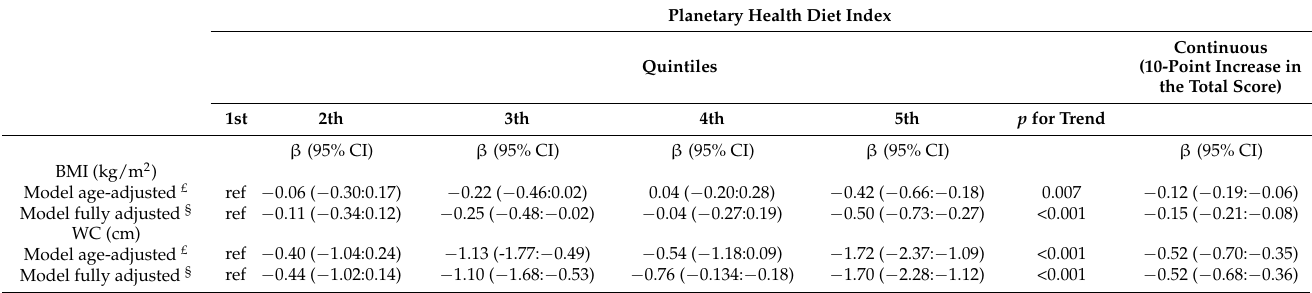
Table 2. Multiple linear regression of the association between the Planetary Health Diet Index and obesity indicators. ELSA-Brasil, 2008–2010.